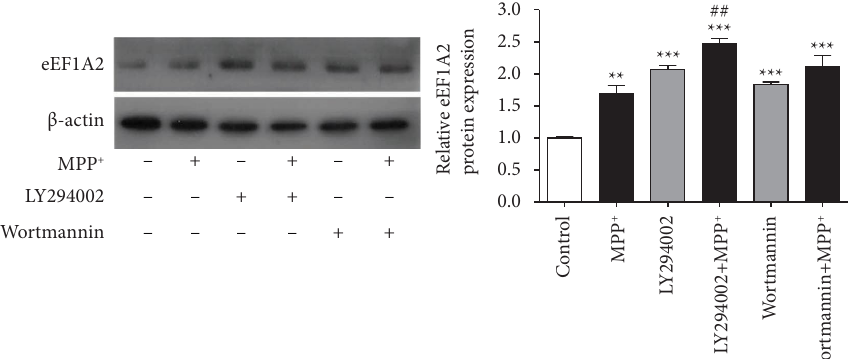
Figure 5: PI3K inhibitors increase eEF1A2 expression. SH-SY5Y neuronal cells were pretreated with 50 μ M LY294002 or 1 μ M wortmannin for 1h followed by exposure to 1000 μ M of MPP + for 24 h. Western blot assay was used to detect the expression of eEF1A2. Te density of the bands was normalized with that of β -actin protein. Data are expressed as mean ± SEM ( n � 3). ∗∗∗ p < 0 . 001 versus control; ## p < 0 . 01 versus MPP + .